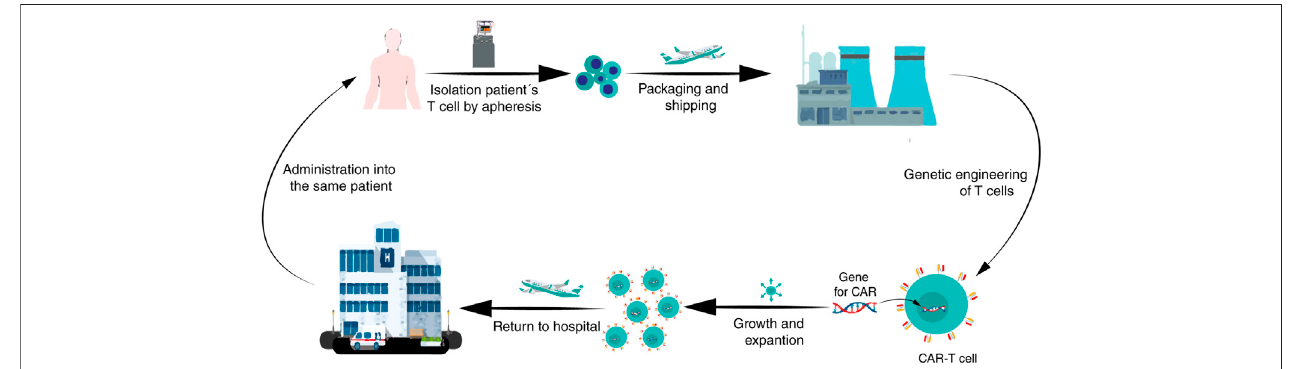
FIGURE 3 | A brief diagram of the CAR-T cells manufacturing process. After enough leukocytes have been harvested from a patient ’ s blood via leukapheresis, T cells are shipped to a biopharmaceutical company where they are genetically engineered to express a CAR on the T cell surface. Then, the CAR-T cells are ampli fi ed in vitro ; after that, the CAR-T cells are returned to the hospital for administration into the